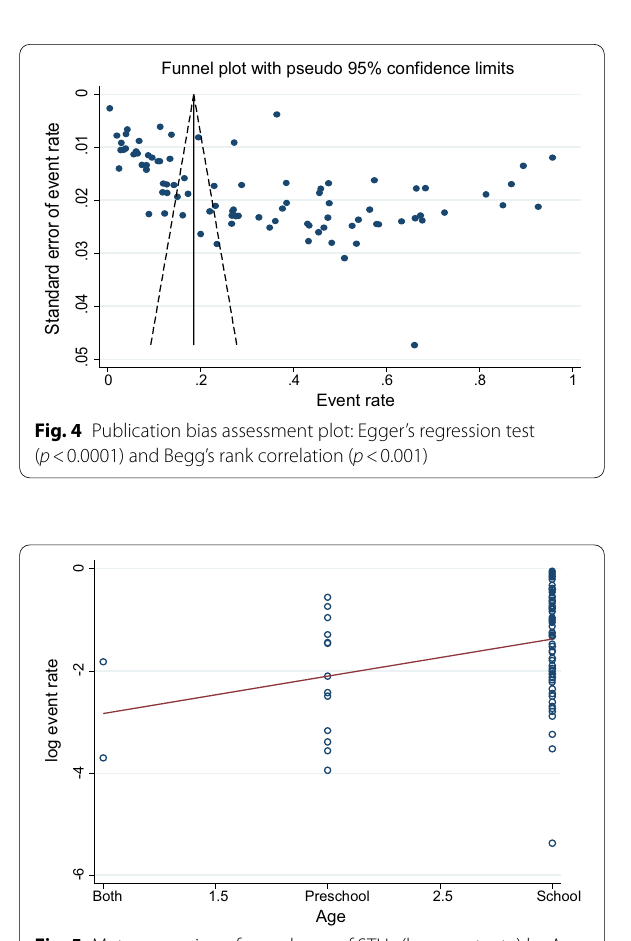
Fig. 5 Meta-regression of prevalence of STHs (log event rate) by Age